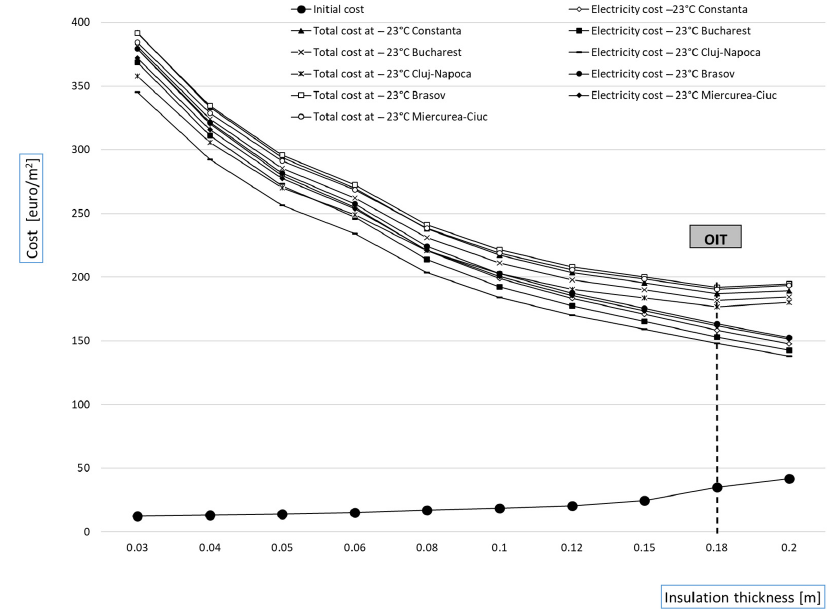
Figure 5. OIT for frozen storage.